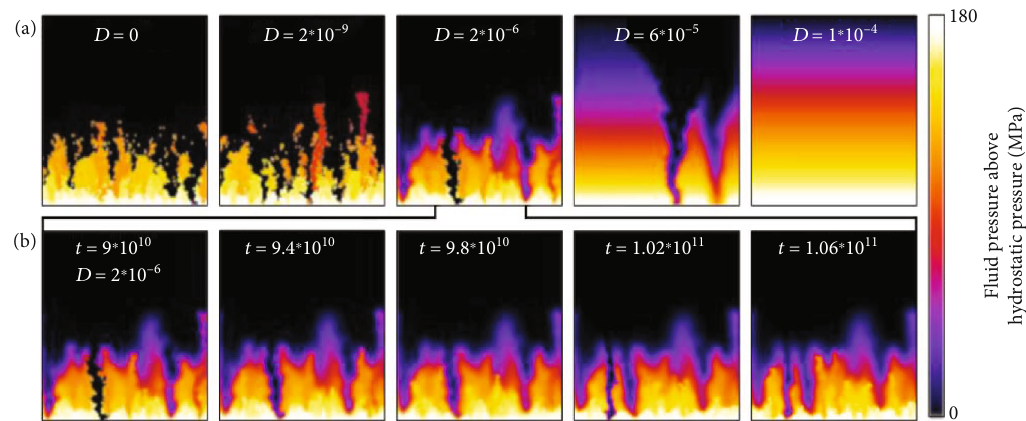
Figure 3: Snapshots of simulation results, in the form of maps of the pressure fi eld. Movies of the model can be found in the supplementary material (available here). (a) Results for di ff erent di ff usion coe ffi cients. (b) Five steps of the simulation with D = 2 ∗ 10 − 6 , starting at a time where one hydrofracture reached the top of the model. Note how the initially sharp boundaries become increasingly fuzzy, as fl uid fl ows (i.e., pressure di ff uses) into the recently drained